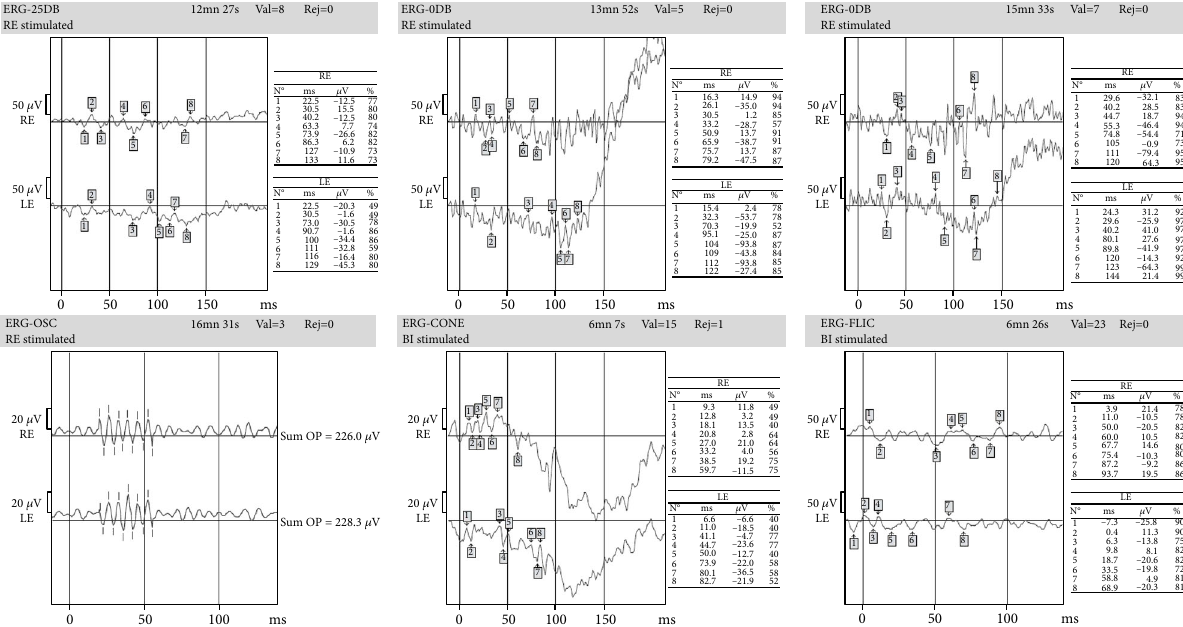
stimulatedERG-CONE BI